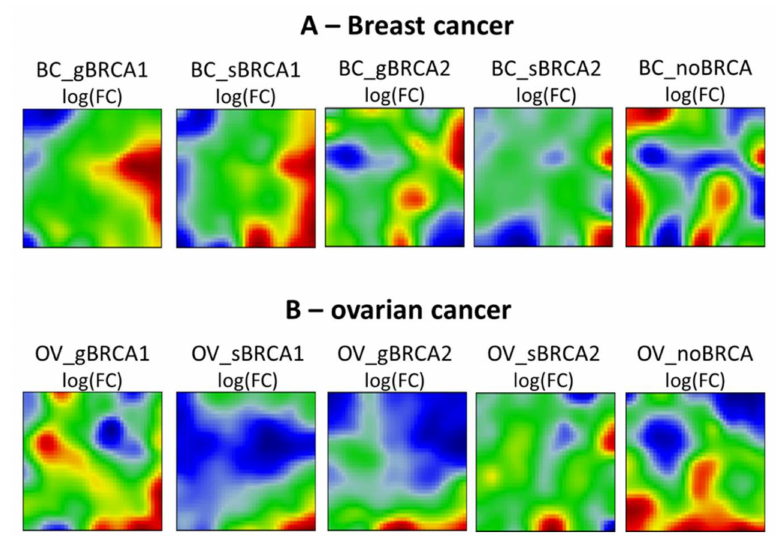
Figure 1. Group-specific mean expression portraits of breast ( A ) and ovarian ( B ) cancers (see Table 1). Spot-like red and blue areas indicate clusters of genes that are concertedly up- or down-regulated in each of the group portraits. Notably, genes are position-invariant in all portraits, meaning that all portraits can be compared each with another.